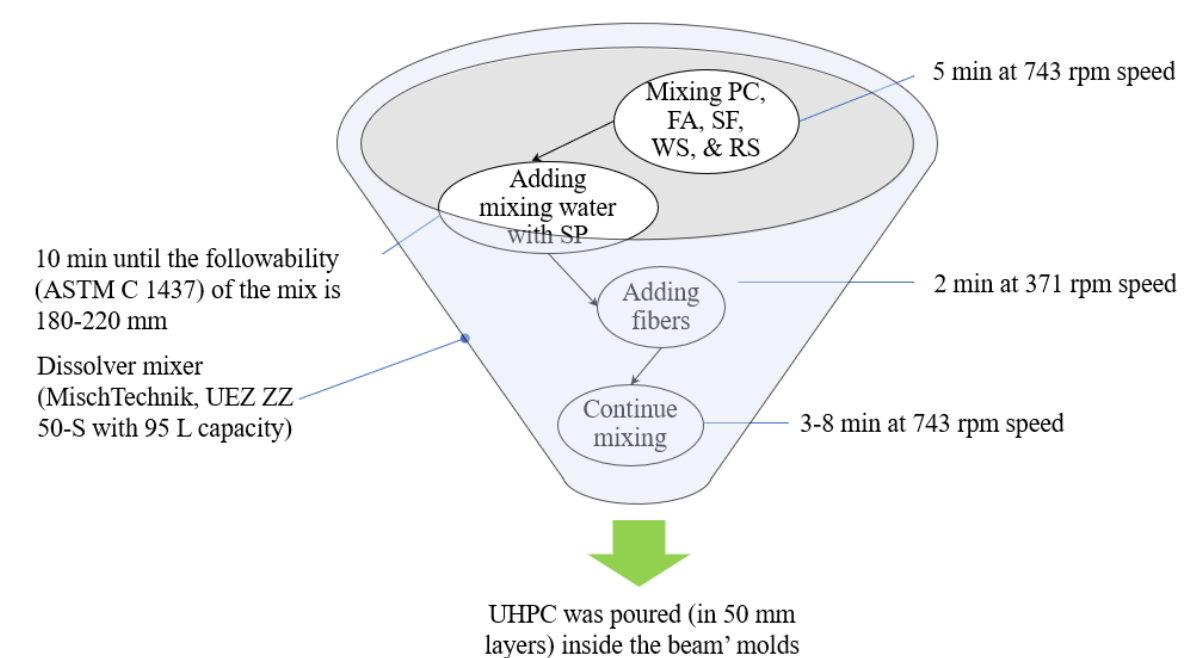
Figure 3. The process for producing the UHPC.